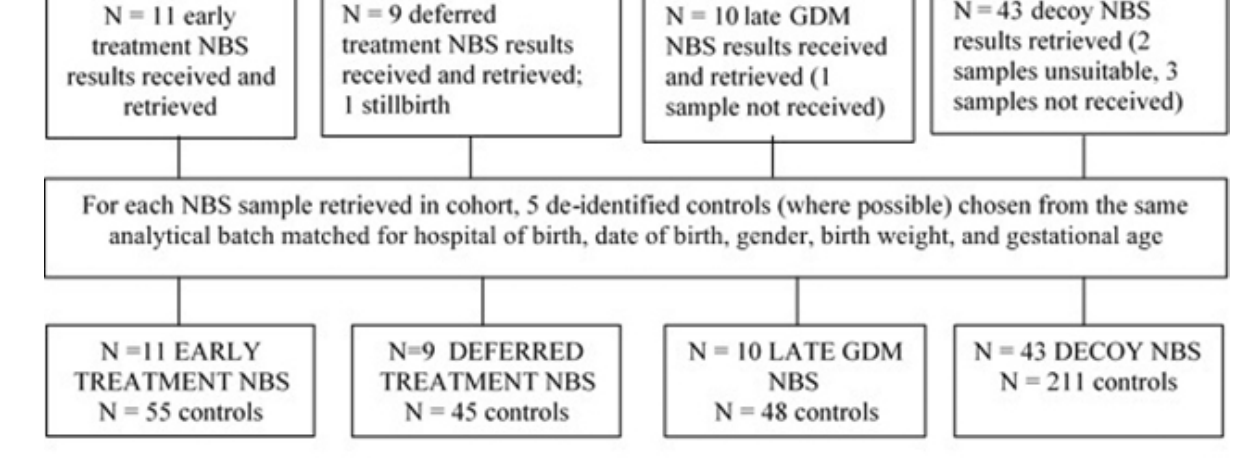
Figure 1. Overview of study